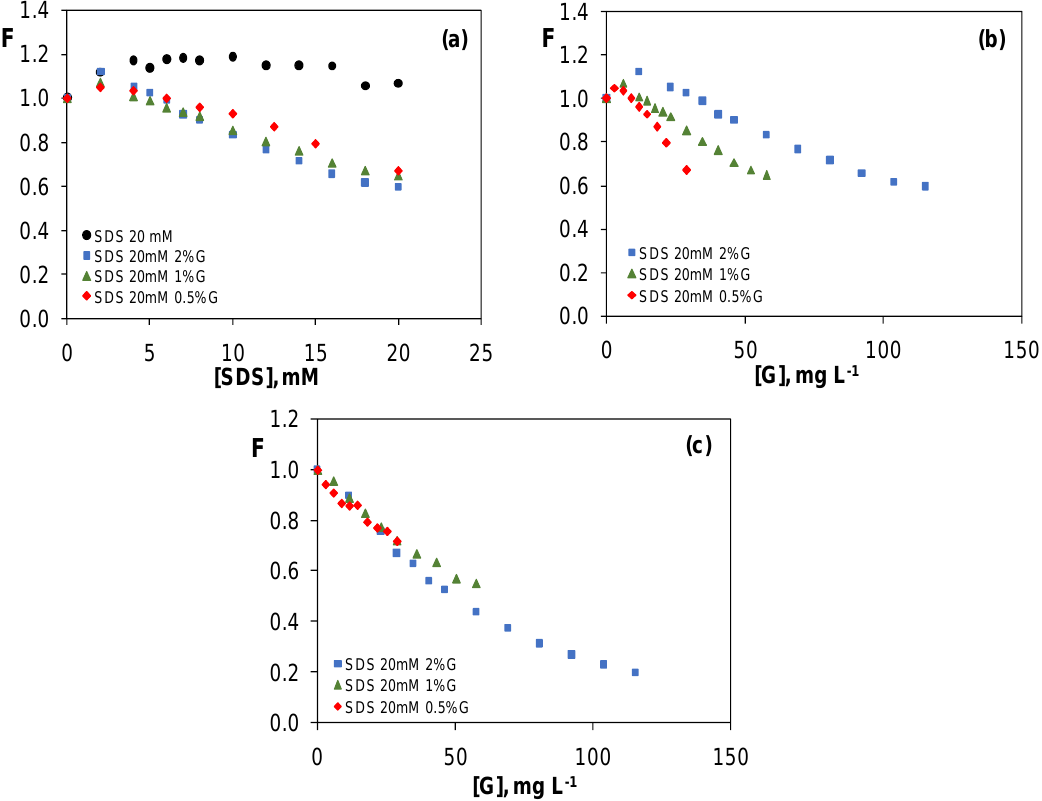
Figure 4. Evolution of the fluorescence of vitamin B 6 ( λ exc = 325 nm; λ em = 395 nm) in the presence of G dispersions in 20 mM SDS vs. surfactant ( a ) and graphene ( b , c ) concentration for solutions with a constant G/SDS weight ratio ( a , b ) or constant SDS concentration ( c ).